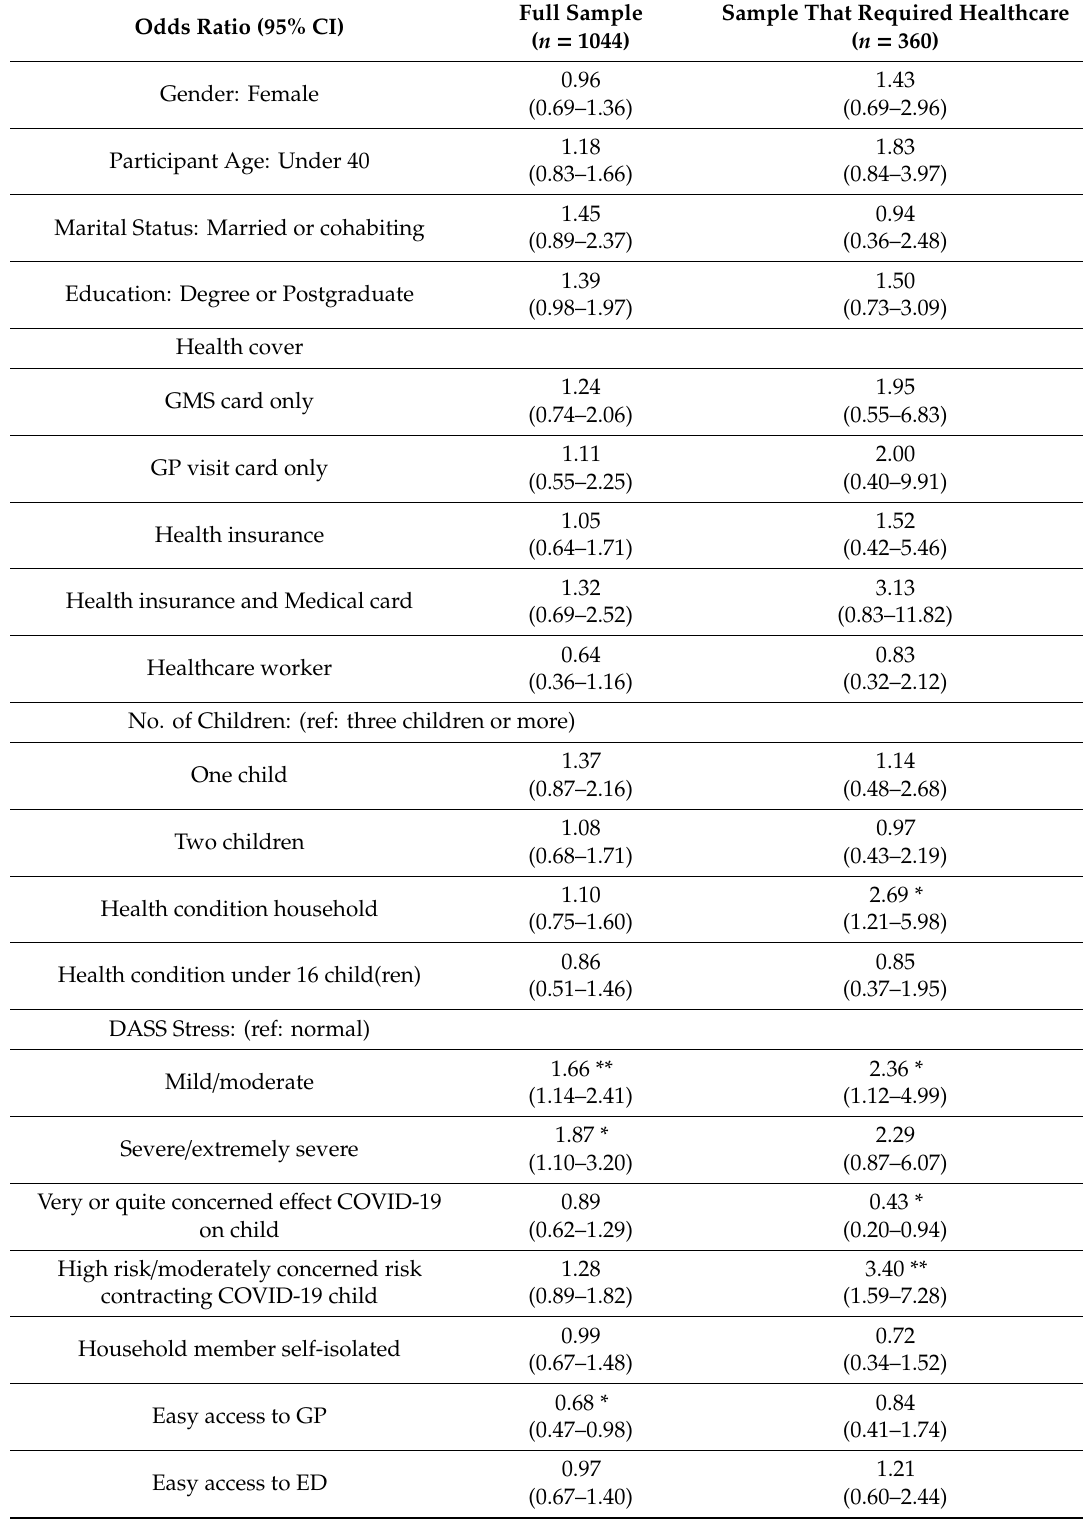
Table 3. Logistic regression results for participants who believed government advice was to stay away from health